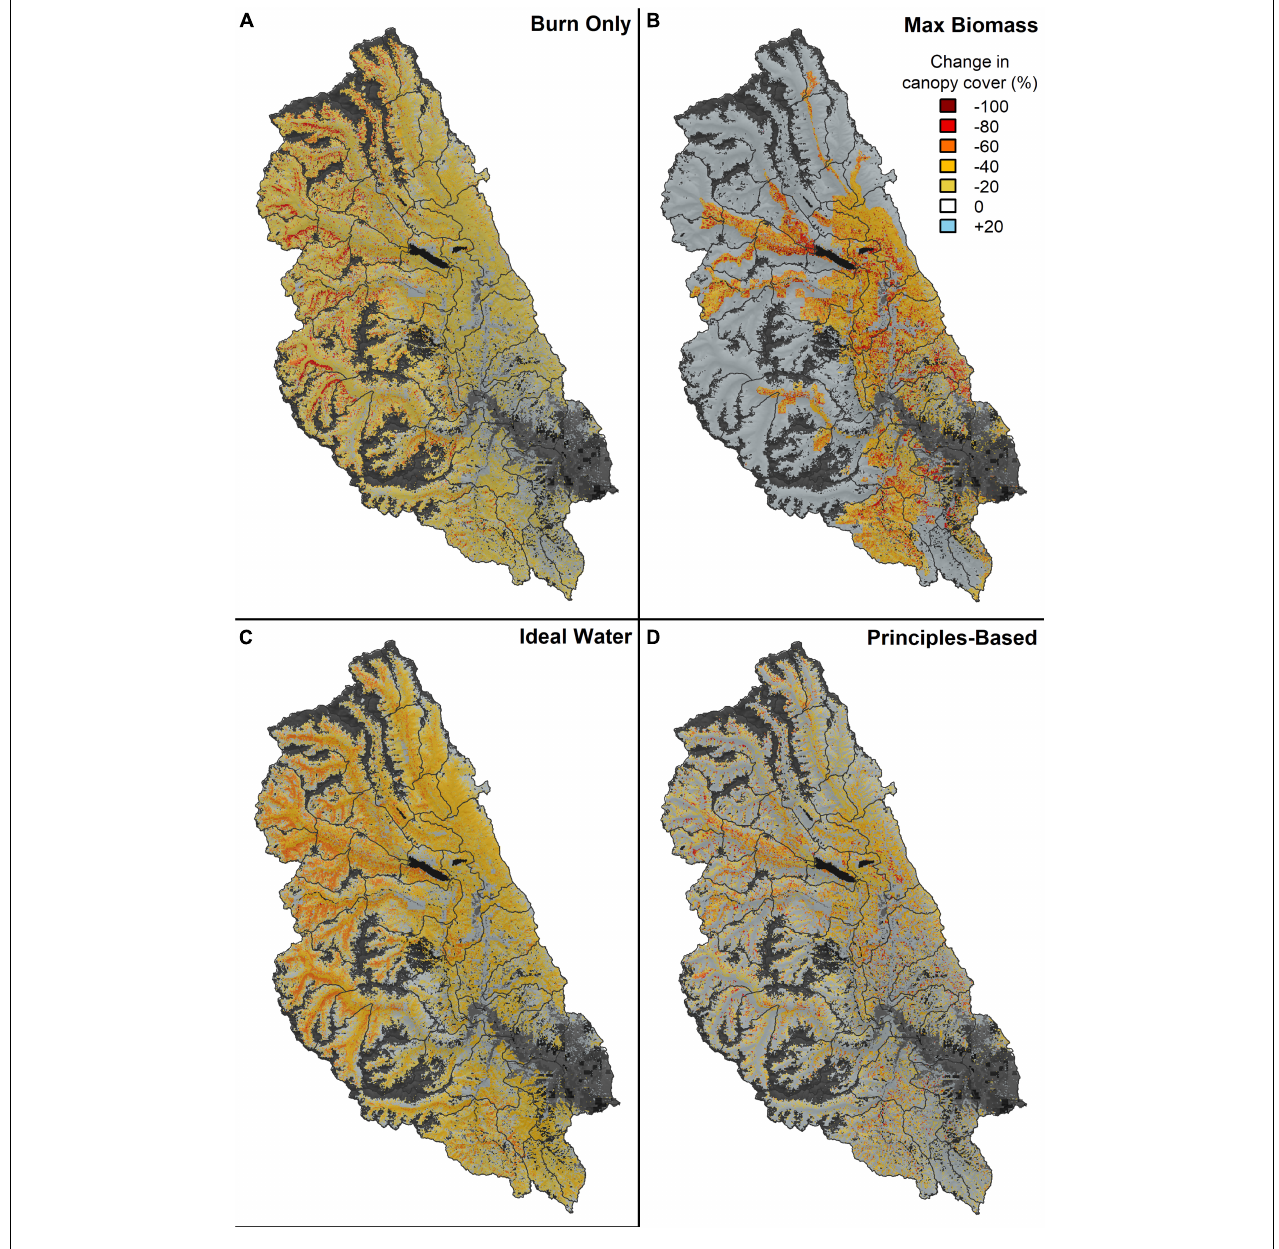
FIGURE 2 | The simulated effects of the four management scenarios on percent canopy cover for the (A) prescribed burn only, (B) max biomass, (C) ideal water, and (D) principles-based scenarios. Dark gray areas represent non-forested area, and black indicates